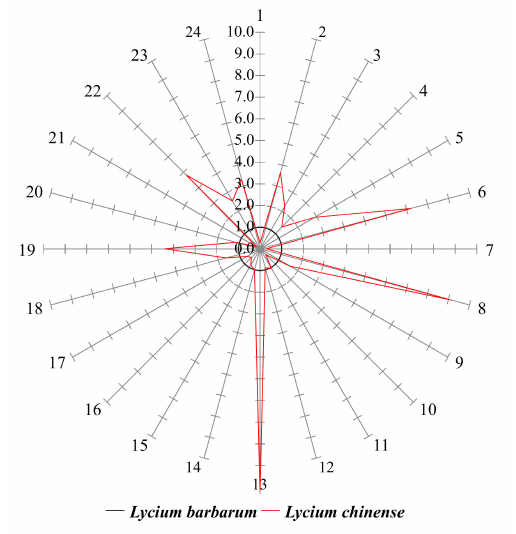
Figure 2. Amino acid star symbol plot of the normalized values in Table 1. The numbers on the rays correspond to the row no. in Table 1.